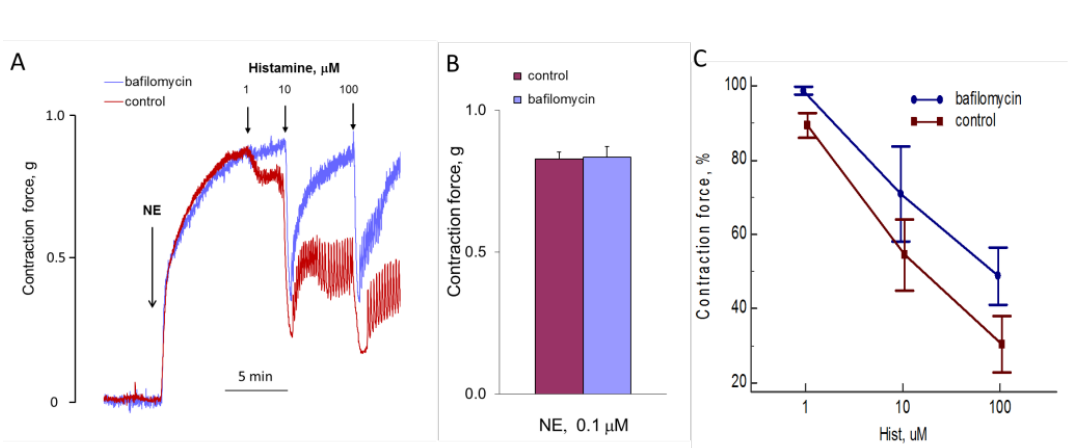
Figure 13. Influence of bafilomycin A1 on the e ff ects of NE and histamine on aortic tone. ( A ) The kinetics of the contraction of the rings and relaxation in response to NE and histamine in the absence and presence of bafilomycin A1. Results of one of five typical experiments are presented. ( B ) The force of NE-induced contraction with or without bafilomycin A1. ( C ) The force of contraction (at points of maximal relaxation) in response to histamine of aortic rings incubated with or without 0.5 µ M bafilomycin A1 during 1 h before adding of 0.1 µ M NE. Values (B,C) are the means + SEM of five independent experiments. In panel C, there is a significant di ff erence between control and bafilomycin A1 ( p <